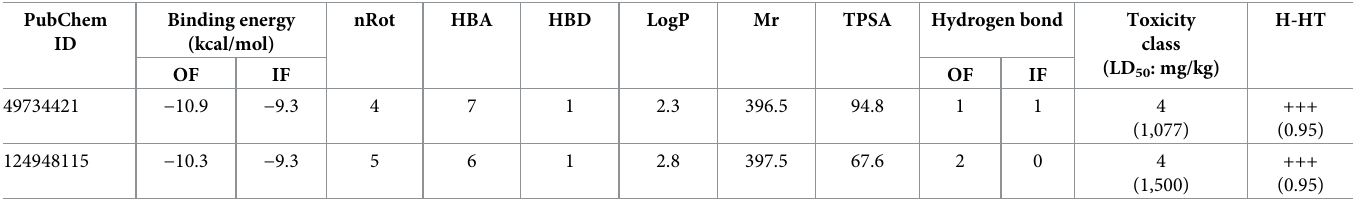
Abbreviations: nRot, number of rotatable bonds; HBA, hydrogen bond acceptors; HBD, hydrogen bond donors; H-HT, human hepatotoxicity; LogP, lipophilicity; Mr, molecular weight; TPSA, topological polar surface